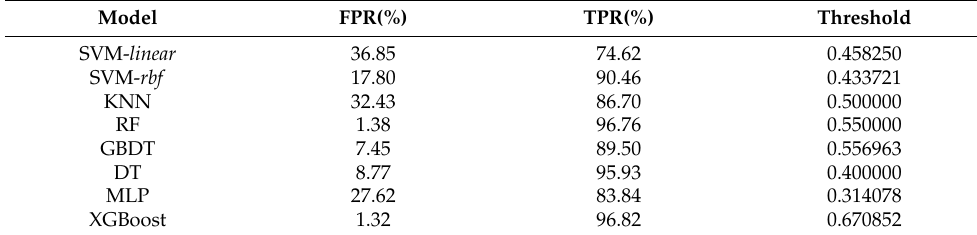
Table 5. Optimal thresholds of each